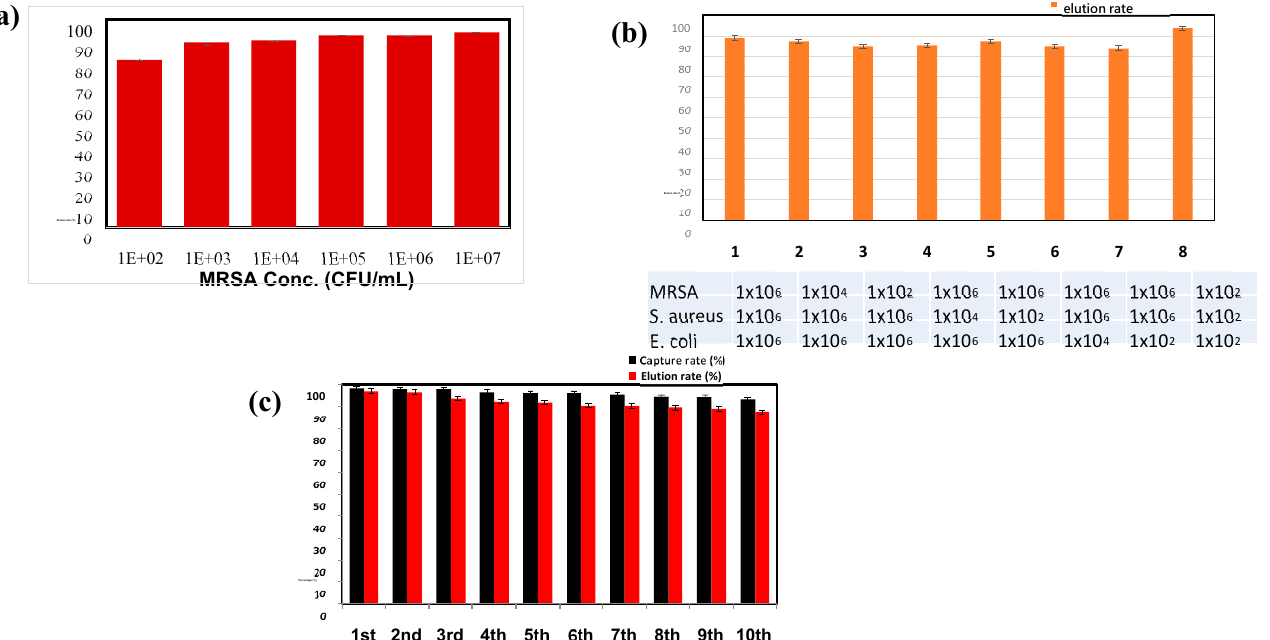
Figure 6. ( a ) Elution efficiency of MRSA bacteria at different concentrations (10 2 –10 7 CFU/mL). ( b ) Elution of captured MRSA from PAMNP-aptamer in samples containing bacteria mixtures of three species mixed at different concentrations. ( c ) Capture and elution percentages for the PAMNP-aptamer approach during 10 consecutive cycles of experiments.